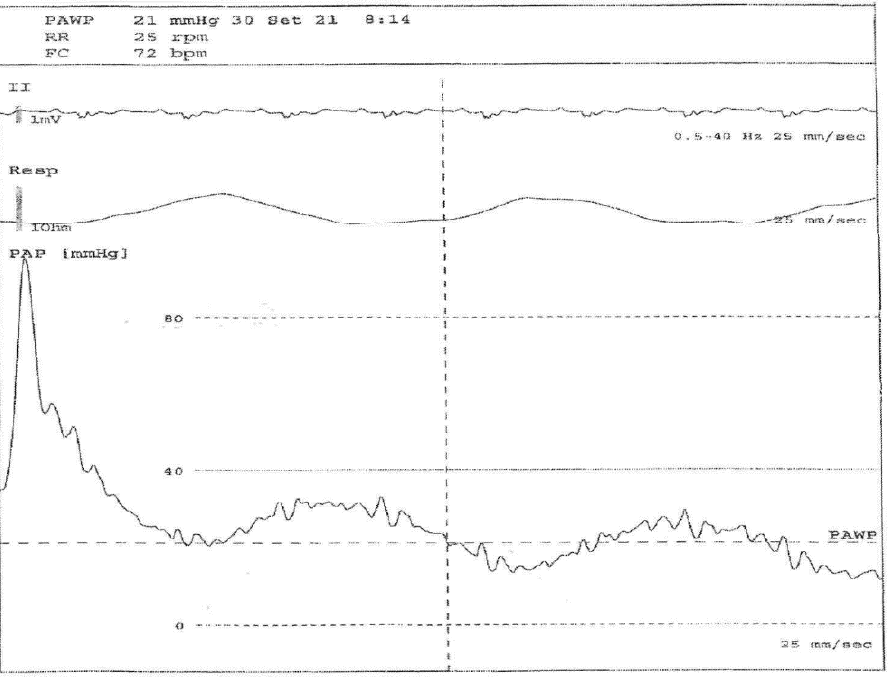
Figure 1. Right heart catheterization (RHC) evaluation in a 56-year-old systemic sclerosis patient with pulmonary arterial hypertension (PAH). Legend: From below: pulmonary arterial pressure, respiratory and EKG waveforms during arterial catheterization. The first part of the pressure trace reflects the pressure in a pulmonary artery (large swings, dicrotic notch), then the balloon is inflated and the tip of the Swan–Ganz catheter floats until it wedges in a small artery (small swings synchronous with respiratory rate), allowing a pulmonary arterial wedge pressure (PAWP) to be obtained, which is an indirect measure of left ventricle pressure.